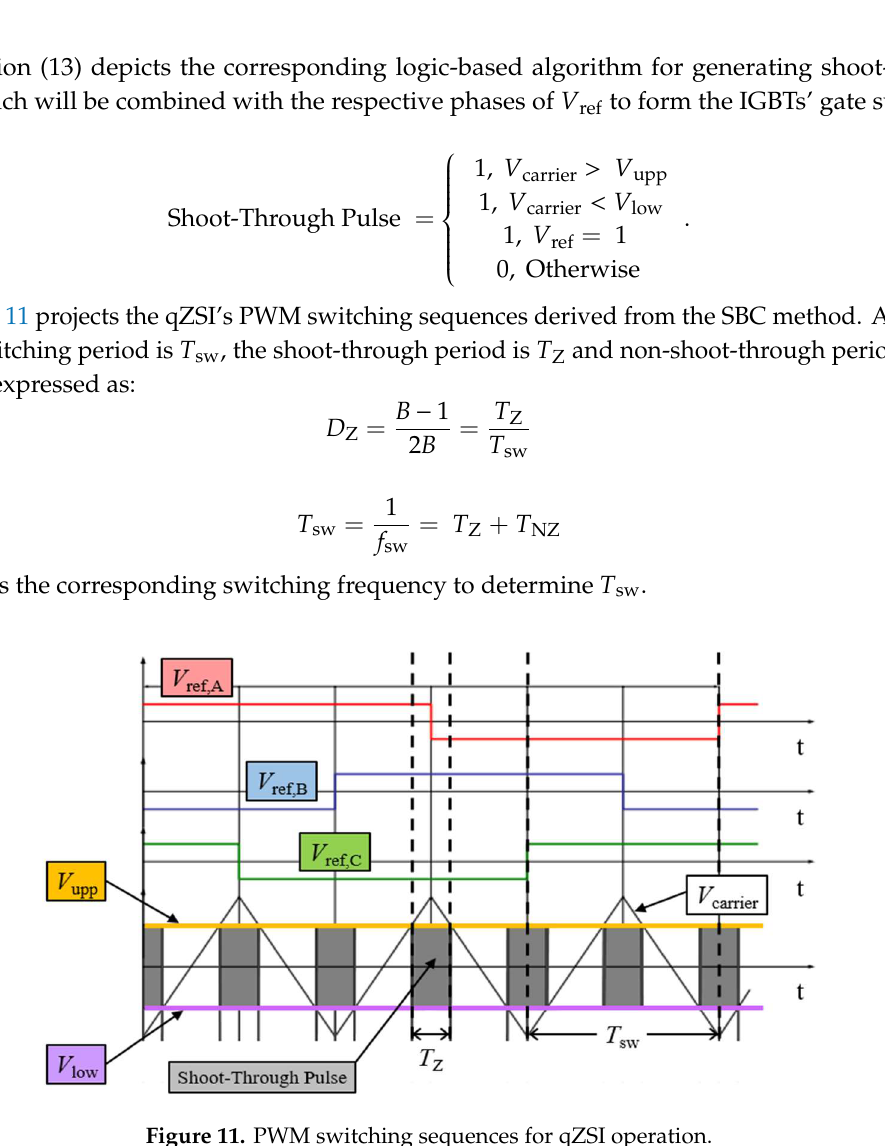
Figure 11. PWM switching sequences for qZSI operation.